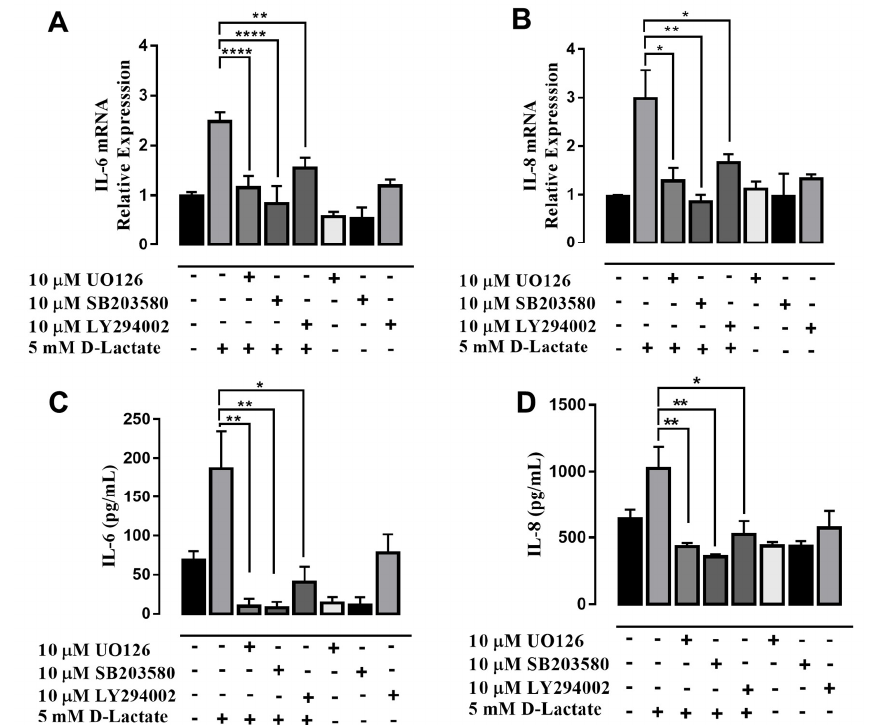
Figure 5. ERK1 / 2, p38 and Akt participate in the increase in IL-6 and IL-8 induced by D-lactate in bFLSs. ( A , B ) The relative mRNA levels of IL-6 and IL-8 in cells treated with UO126, SB203580 and LY294002 and then stimulated with D-lactate, normalized by S9 ribonucleoprotein (housekeeping gene), are shown. ( C , D ) The IL-6 and IL-8 concentrations in the supernatants of bFLSs treated with UO126, SB203580 and LY294002 and stimulated with D-lactate were measured by ELISA. The mean ± SEM of five independent experiments is shown. * p < 0.05, ** p < 0.01, **** p < 0.0001, compared with control or D-lactate-treated cells.